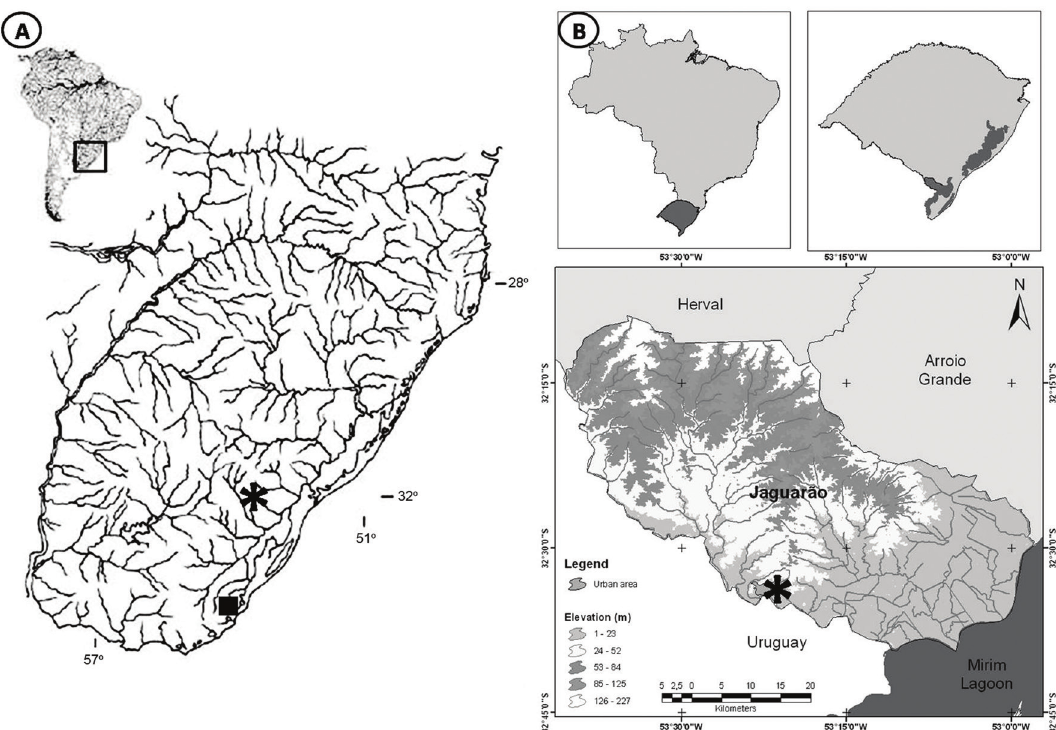
Fig. 2. (A) Occurrence of Austrolebias cheradophilus in Jaguarão River basin, Patos-Mirim Lagoon system, southern Brazil (asterisc), and previous record of the species closest to Brazil (Black square). (B) Map detailing the occurrence of the species in lower Jaguarão River, Patos-Mirim Lagoon system, southern